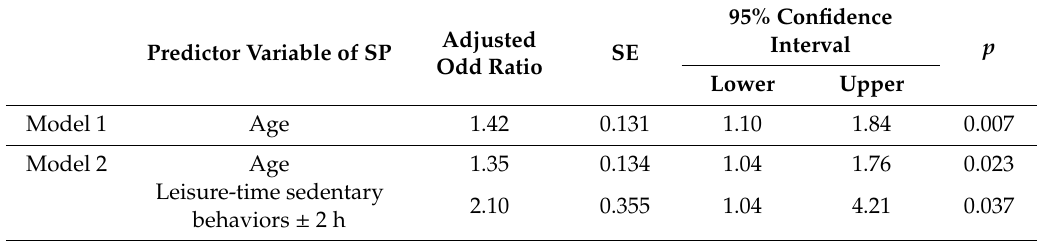
Table 6. Stepwise multiple logistic regression analysis of the predictor variable of SP according to age and leisure time sedentary